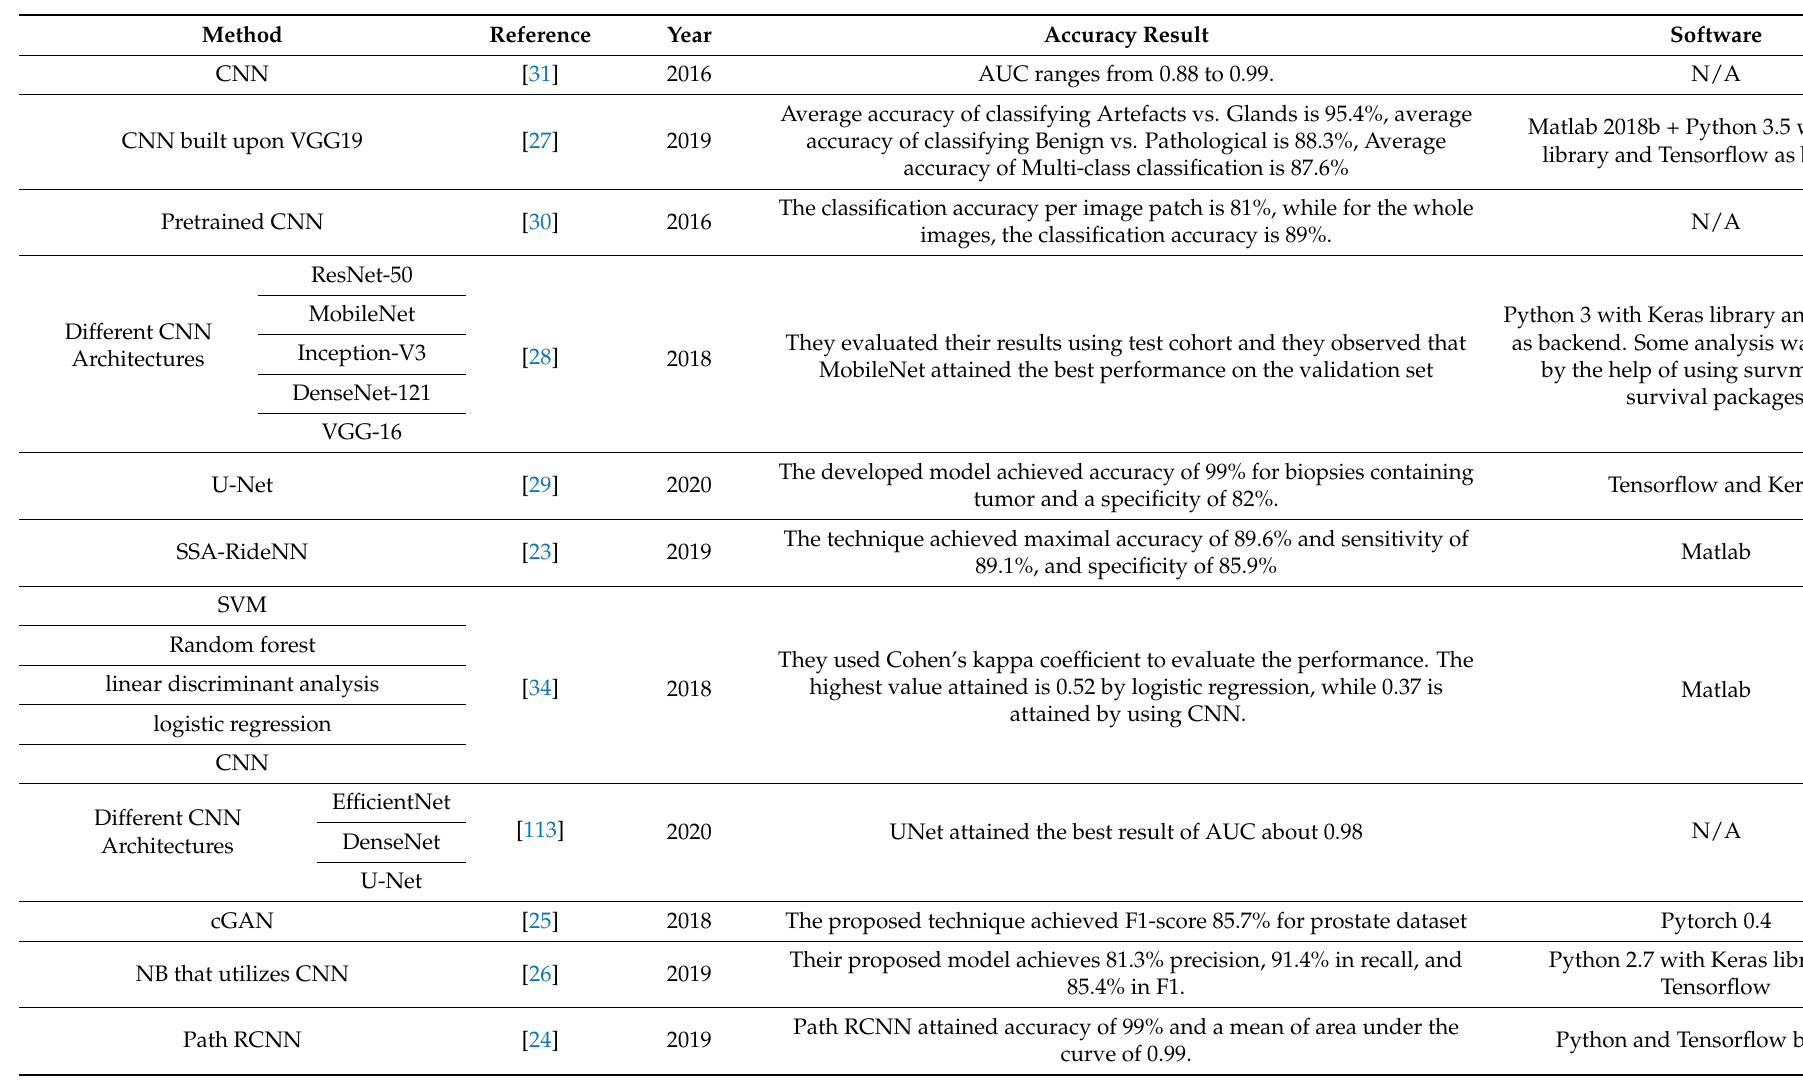
Table 5. Summary of publications focused on applying deep learning methods for prostate histopathology